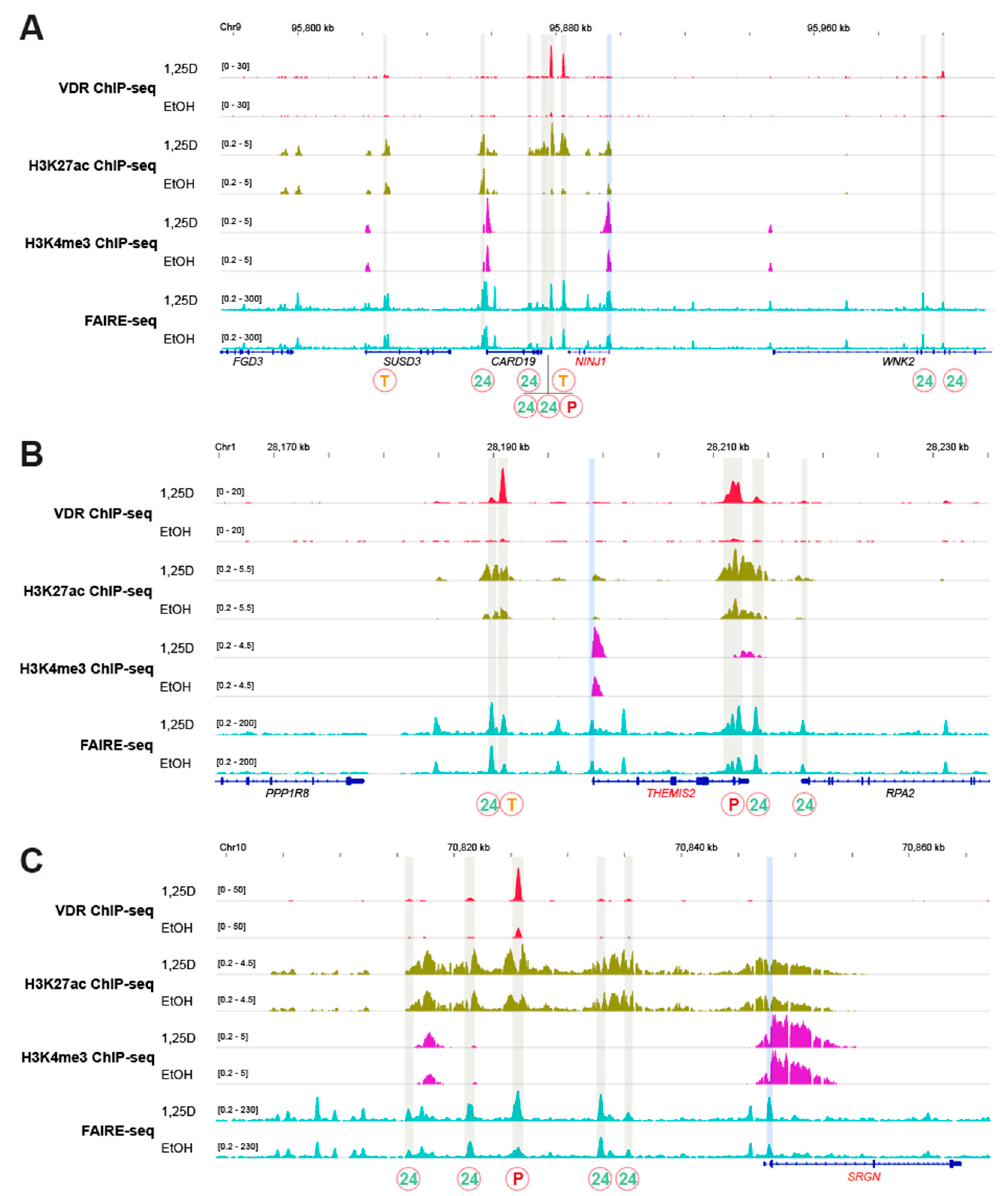
Figure A1. Vitamin D target genes controlled by super-enhancers. The IGV browser was used to visualize VDR ChIP-seq results (red) obtained in THP-1 cells that had been treated for 24 h with 1,25(OH) 2 D 3 (1,25D) or solvent (EtOH) [28]. VDR-bound enhancers are shaded in grey and TSS regions of vitamin D target genes in blue. The type of VDR binding sites at enhancers is indicated as persistent (P), transient (T) or 24 h only (24) [28]. These data are compared with ChIP-seq results obtained under the same conditions for histone markers of active chromatin (H3K27ac, green) [35] and active TSS regions (H3K4me3, purple) [35] as well as with FAIRE-seq data (turquoise) [29]. The peak tracks display merged data from the three biological repeats. Gene structures are shown in blue and the vitamin D target genes NINJ1 ( A ), THEMIS2 ( B ) and SRGN ( C ) are highlighted in red. The genomic regions 1 Mb up- and downstream of the gene’s TSS were inspected but only the areas relevant for 1,25(OH) 2 D 3 -dependent regulation are displayed.